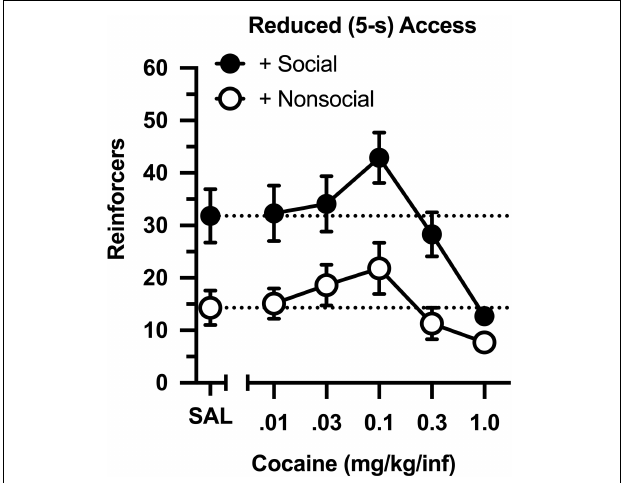
FIGURE 3 | Number of reinforcers obtained during daily, 60-min test sessions under reduced (5-s) access conditions. Data reflect the mean (SEM) number of infusions from rats assigned to the social (“+ Social,” filled symbols; n = 12) and non-social (“+ Non-social,” open symbols; n = 9) groups. Responding was maintained by various doses of cocaine (0.01–1.0 mg/kg/inf) and either a social (sex- and age-matched partner) or non-social (black-and-white athletic sock) stimulus. Dashed lines originating at the X-intercept reflect the average number of infusions during a saline substitution test (SAL).